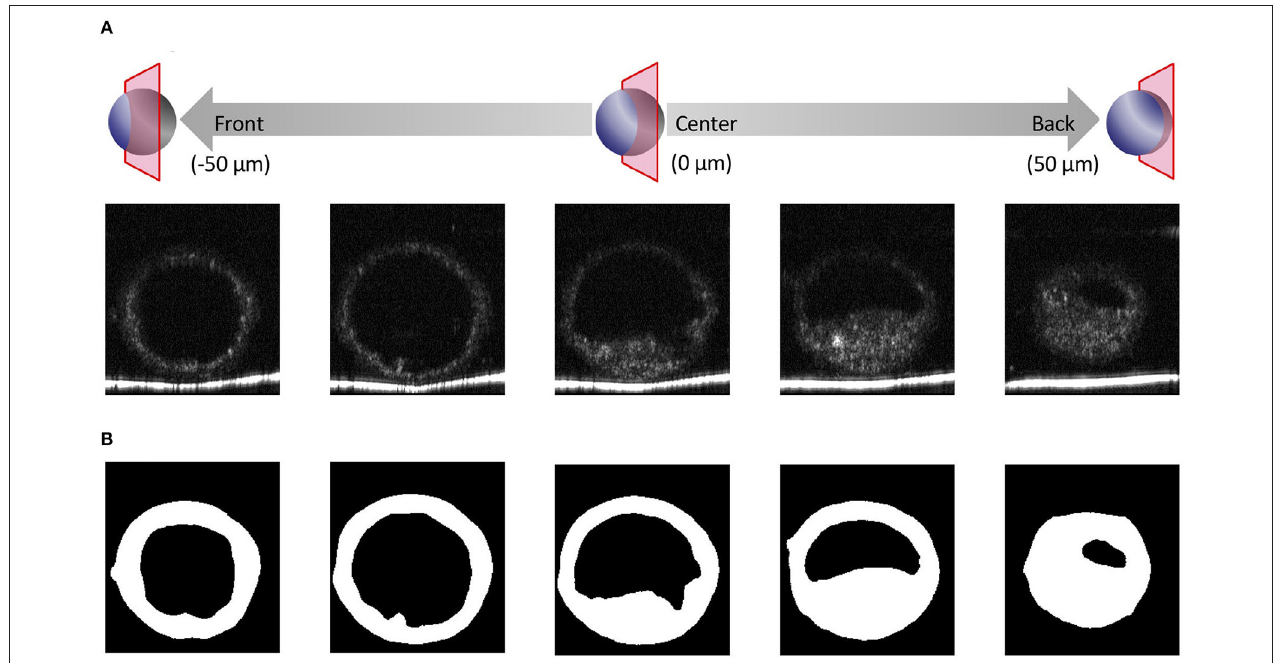
FIGURE 2 | Optical coherence tomography (OCT) images of the bovine embryo and each structure of an embryo. (A) Tomographic images obtained by OCT imaging. Panels are images shifted by 25 µ m from the center of the embryo. (B) Based on the tomographic images, the structure of the embryo is visualized and binarized.